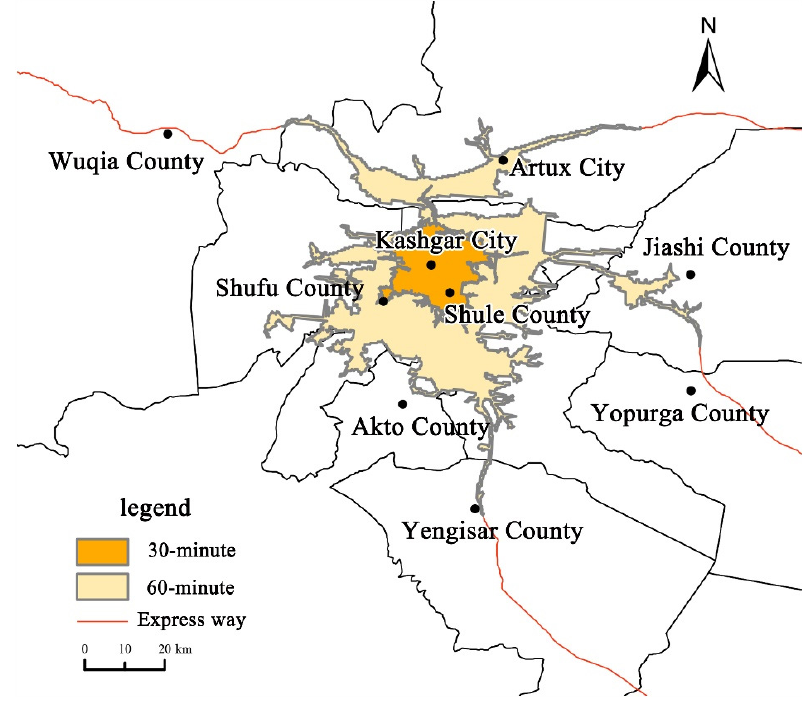
Figure 11. A map of 30 ‐ min and 60 ‐ min traffic isochronous circles.